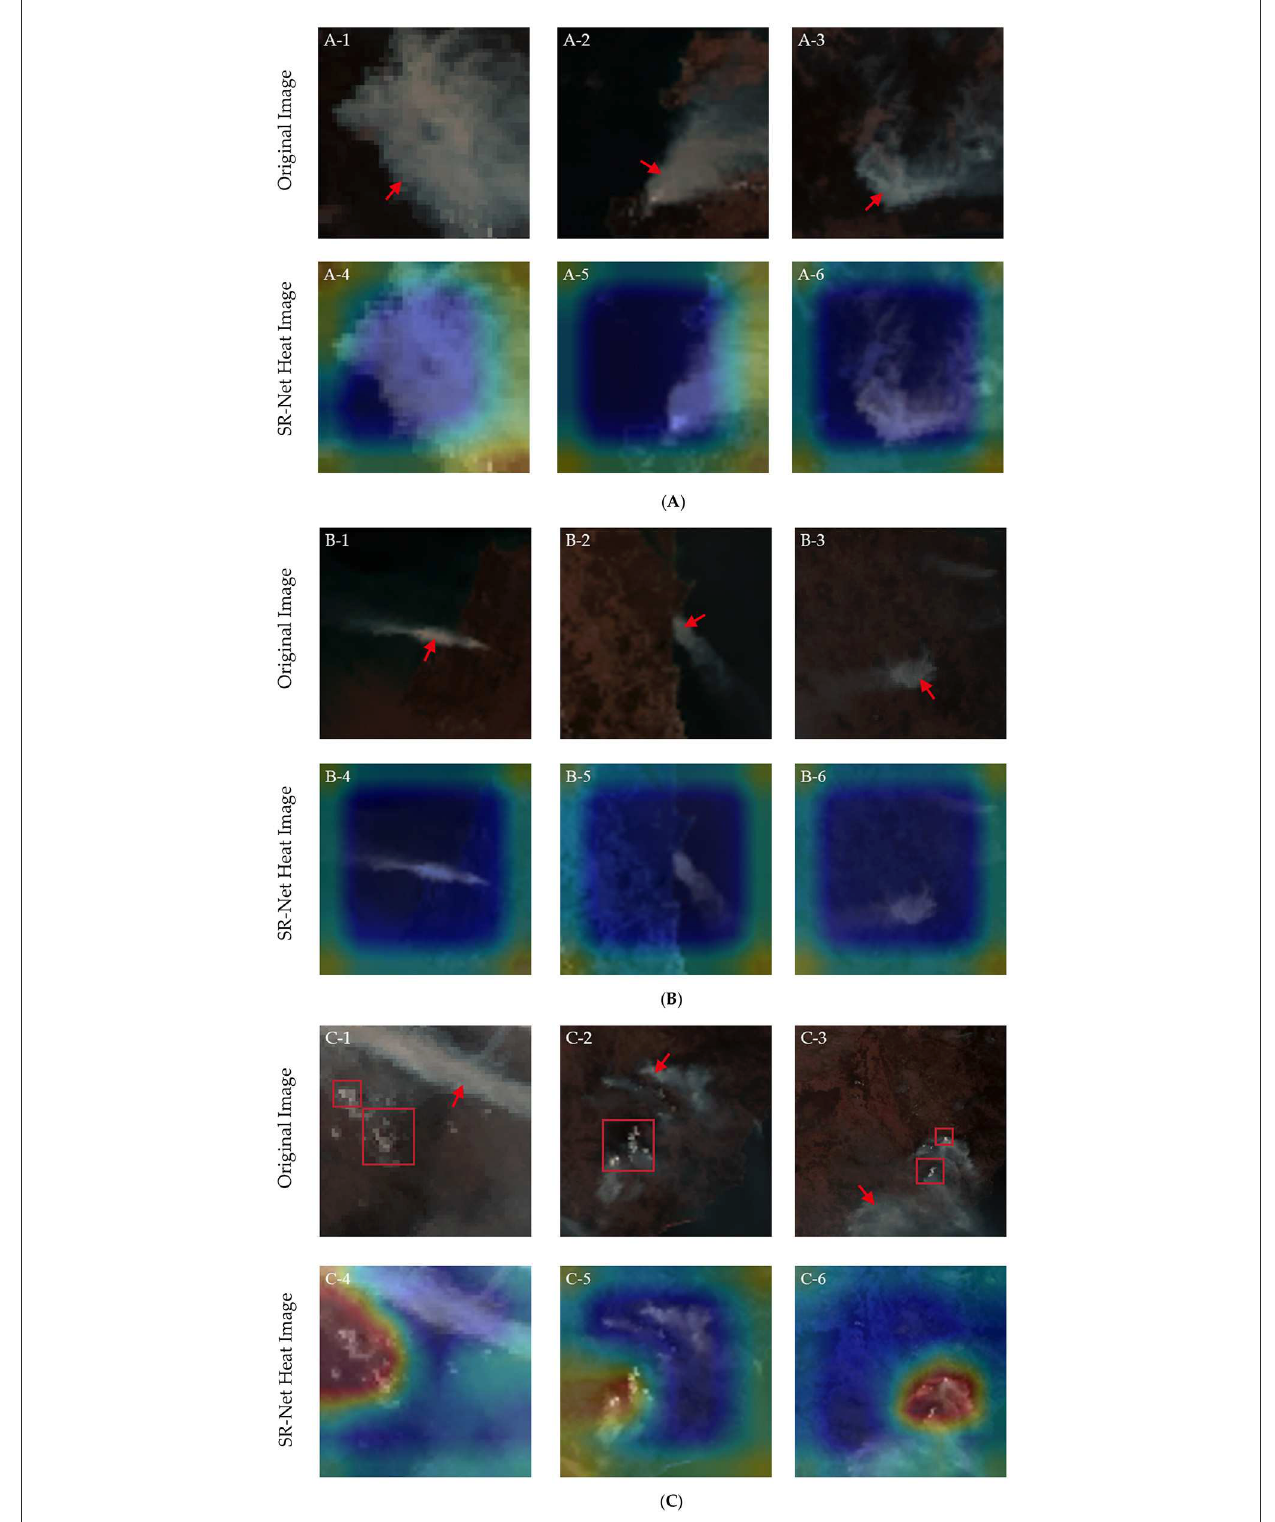
FIGURE6 Comparison between the original remote sensing images of forest fire smoke and heat images processed by Grad-CAM based on the SR-Net model. (A) The proportion of smoke area > 30%, (B) the proportion of smoke area < 20%, (C) situations when there is a small portion of clouds (marked with red rectangles) in the original smoke images. The attention distribution when the model detects forest fire smoke is marked with blue, yellow, and red in descending order of weight from high to